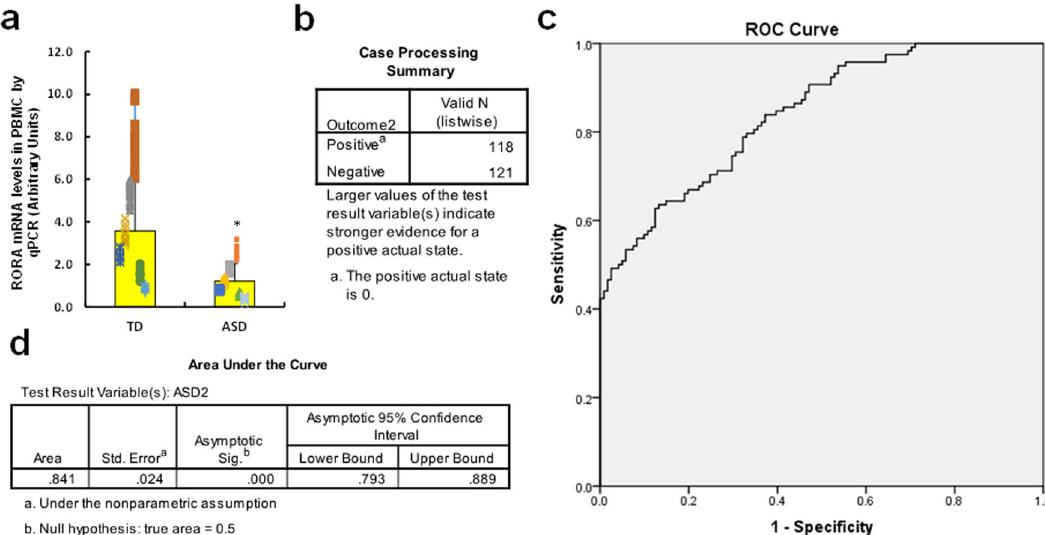
Fig. 8 Establishment of ROC curve as an autistic marker based on RORA expression. a Three milliliter of peripheral blood was withdrawn from either typical developing (TD, n = 118) and ASD ( n = 121) children (2 – 6 years old), and the PBMC were isolated for RORA mRNA analysis through real-time quantitative PCR. b – d The RORA mRNA levels were used to draw the ROC (receiver operating characteristic) curve. b Case processing summary, positive represents TD cases, and negative represents ASD cases. c ROC curve. d Area under the curve. *, P < 0.0001, vs. TD group. Data were expressed as mean ± SEM.